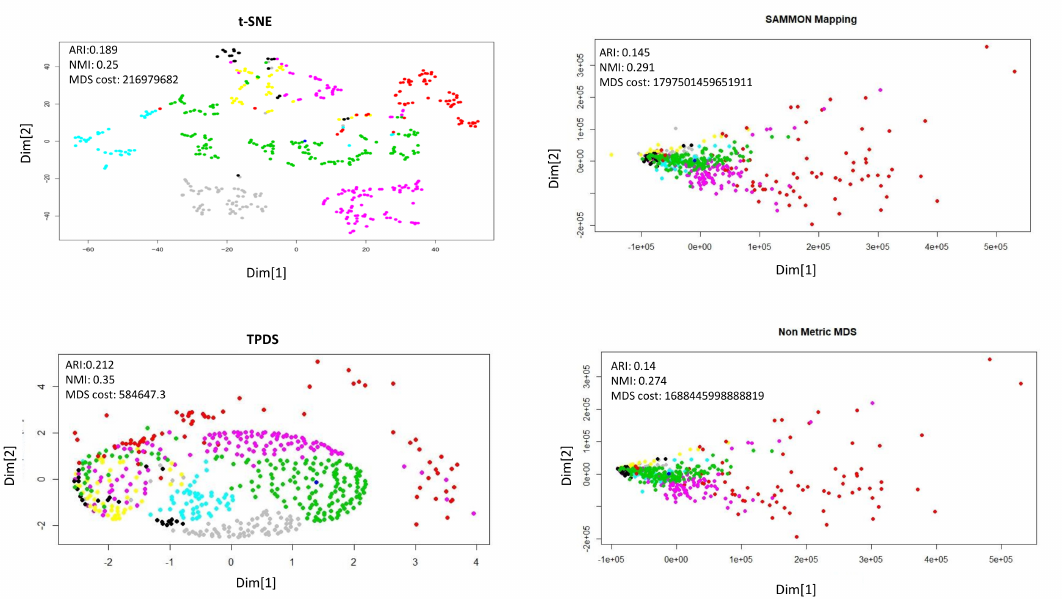
Figure 5. Dimension reduction of single-cell expression data. The 7 types of cells are shown with di ff erent colors. The adjusted Rand Index (ARI) and Normalized mutual information (NMI) were calculated after k-mean clustering (k = 7). The outlier cells (shown in red color) seem to have di ff erent e ff ect with each dimension reduction method. For demonstration purpose perplexity was set to 4 for t-SNE. The performance of TPDS is substantially better than Sammon mapping and non-metric MDS even in terms of MDS-cost